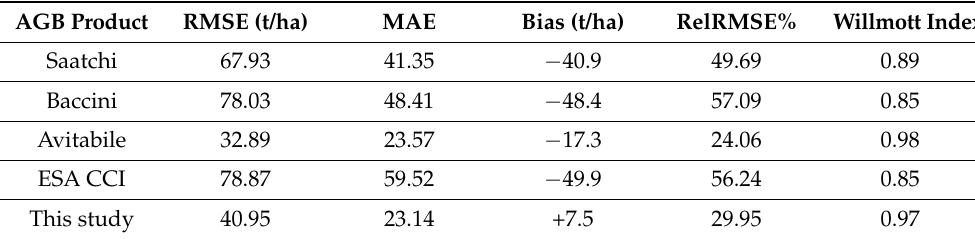
Table 4. Predictive mean errors of the AGB products of the Saatchi, Baccini, Avitabile and ESA CCI products over the Cross River State,